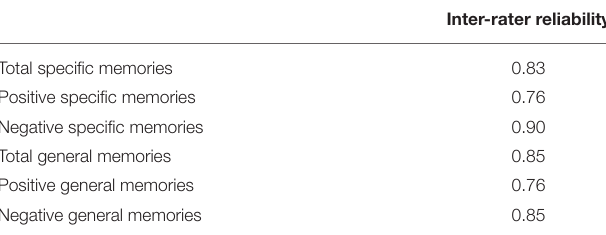
TABLE 1 | Inter-rater reliability statistics for the SCEPT by intraclass correlation